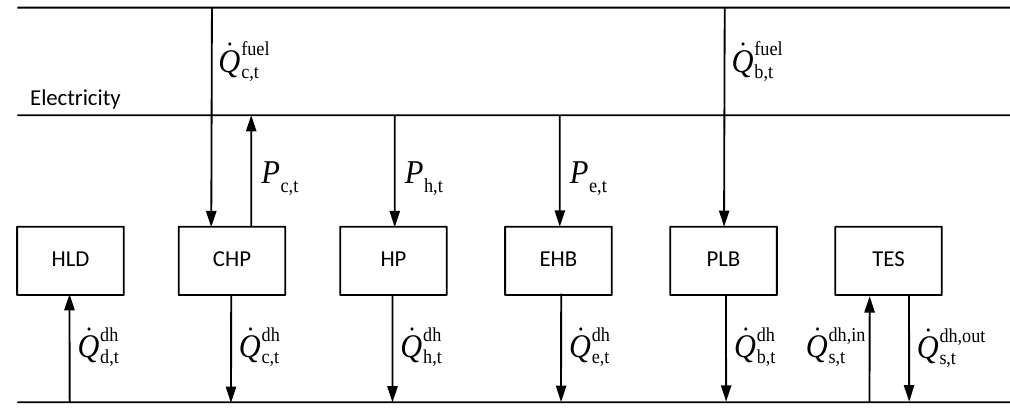
Figure 2. Modeled technologies with related energy flows. (HLD—heat load, CHP—combined heat and power plant, HP—heat pump, EHB—electric heating boiler, PLB—peak load boiler, TES—thermal energy